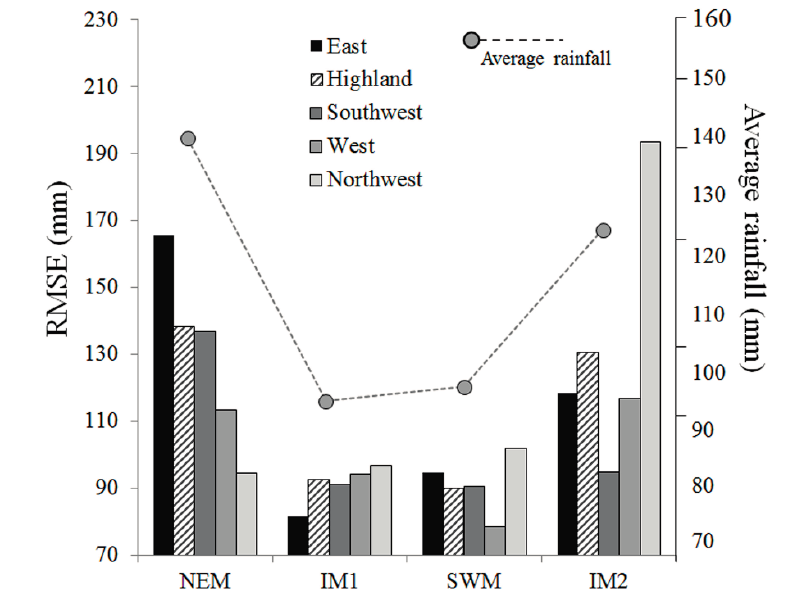
Figure 6. Average seasonal RMSE of the TRMM 3B43 against ground rainfall in local climate regions and average rainfall from areal rainfall surfaces for the period 1998–2010.